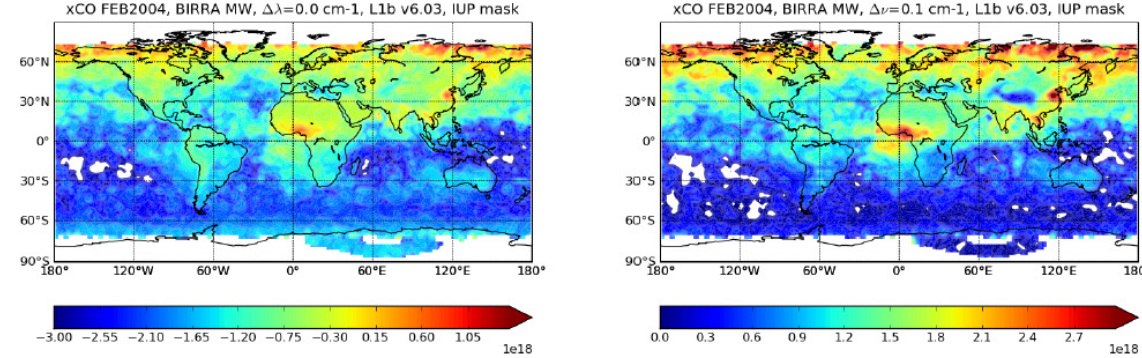
Fig. 10. Comparison of xCO retrievals without (left) and with wavenumber calibration. Note the different color bar with xCO values ranging down to − 3 · 10 18 moleccm − 2 for the unshifted wavenumber retrievals (left). (DBPM provided by M. Buchwitz, personal communication, October